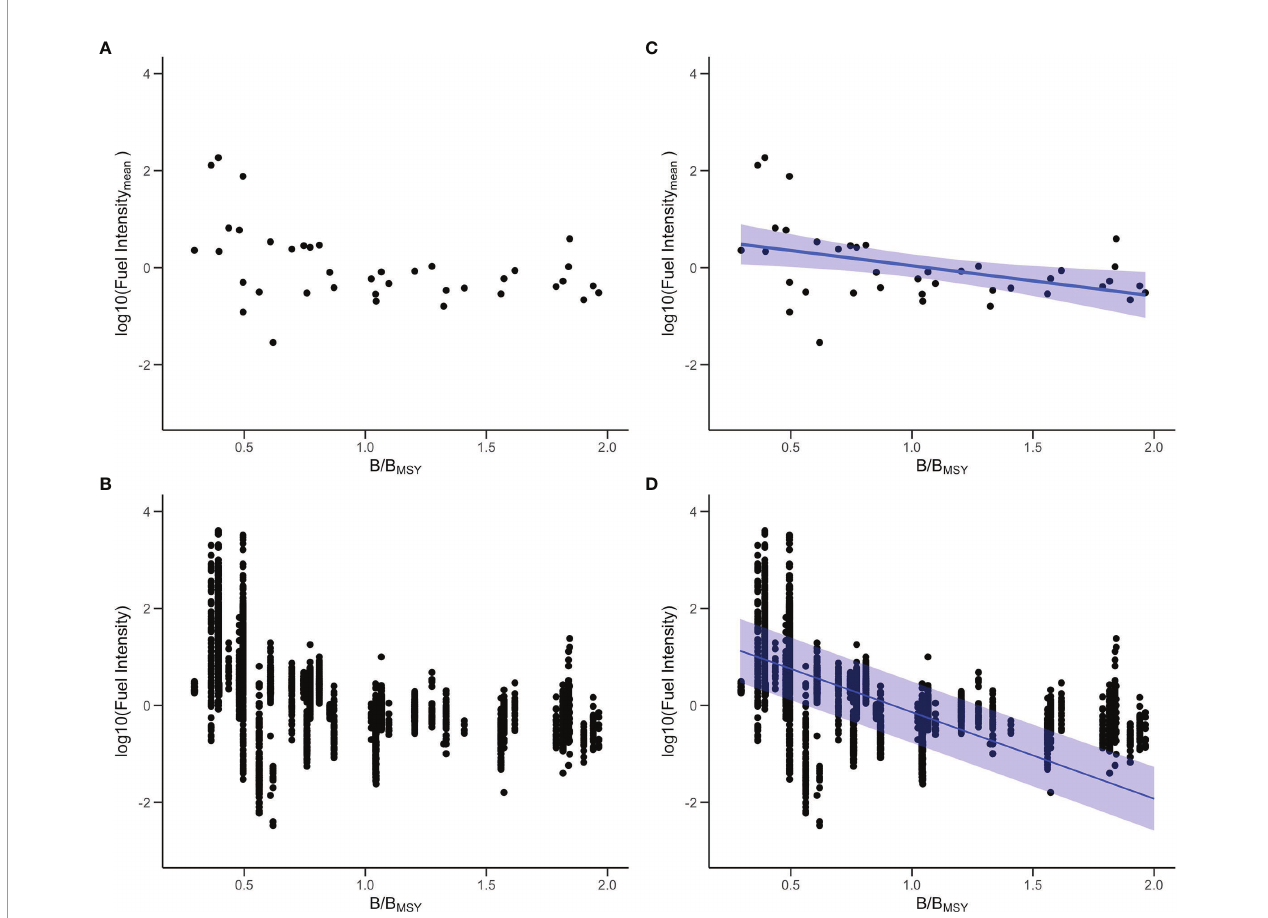
FIGURE 3 | A plot of the raw data showing (A) mean and (B) demeaned values for estimates of fuel intensity. On the x-axis, B/B MSY is plotted from 0.25 to 2.0, and on the y-axis, the appropriate measure of fuel intensity is plotted in log10 scale. In panels (B) and (D) , each point represents a unique B/B MSY -fuel intensity combination derived from an individual fi shing trip, and in panels (A) and (C) , each point represents a unique B/B MSY - Fuel Intensity mean combination associated with a particular Stock-Year. Panel (C) shows the linear regression of B/B MSY versus fuel intensity, where the blue line represents the predicted relationship, and the band around the line depicts 95% con fi dence intervals; note that the R 2 adj . for this simpli fi ed linear relationship is 0.17 ( p value < 0.01). Finally, panel (D) shows the results of our mixed effects model, where fuel intensity is predicted by B/B msy (statistically-signi fi cant fi xed effect), as well as “ gear type ” , “ genus ” , and “ year ” modelled as random effects; the blue line represents the relationship predicted by our mixed effects model, and the band around the line depicts 95% con fi dence intervals predicted by the “ effects ” package in R (Fox et al.,